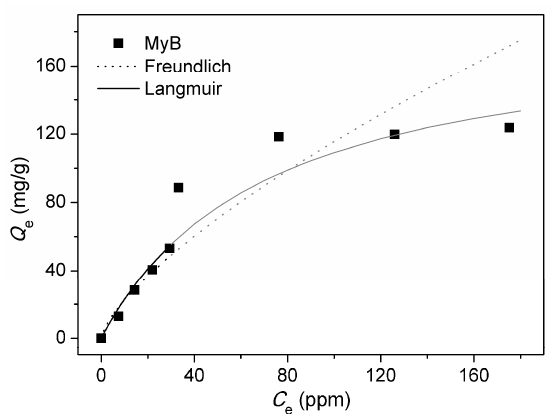
Figure 6. Adsorption isotherm of MyB over adsorbent 1 . Solid and dotted lines refer to the fitted adsorption isotherms for adsorbents by the non-linear Langmuir and Freundlich adsorption isotherm models, respectively. Table 1. Langmuir and Freundlich isotherms for the adsorption of MyB over 1 a . Langmuir parameters